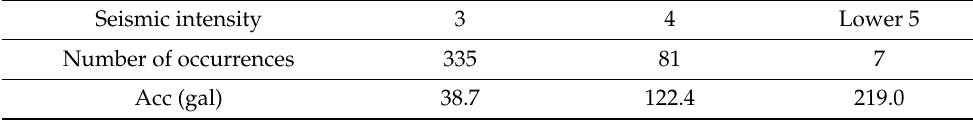
Figure 1. Acceleration time history of a BSL wave. Table 1. Maximum number of occurrences of each seismic intensity over 30